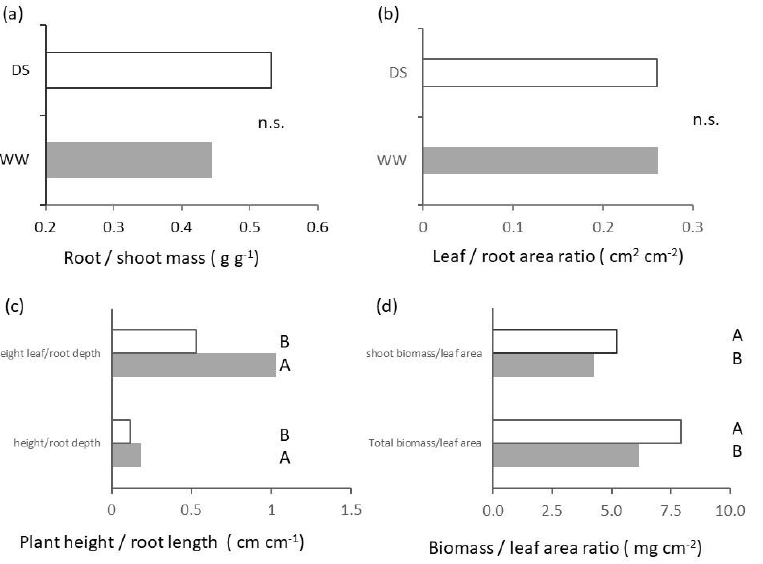
Figure 6. Effect of soil water availability on allometrics. ( a ) Root-to-shoot dry mass ratio; ( b ) biomass-to-leaf area ratio; ( c ) shoot height-to-root depth ratio; and ( d ) leaf-to-root area ratio. White bars: DS; grey bars: WW. Different letters on each bar designate significantly different values at the Tukey’s post hoc mean separation test for p < 0.05 (lowercase letters) or p < 0.01 (uppercase letters), or non-significant differences (n.s.) for p > 0.05.